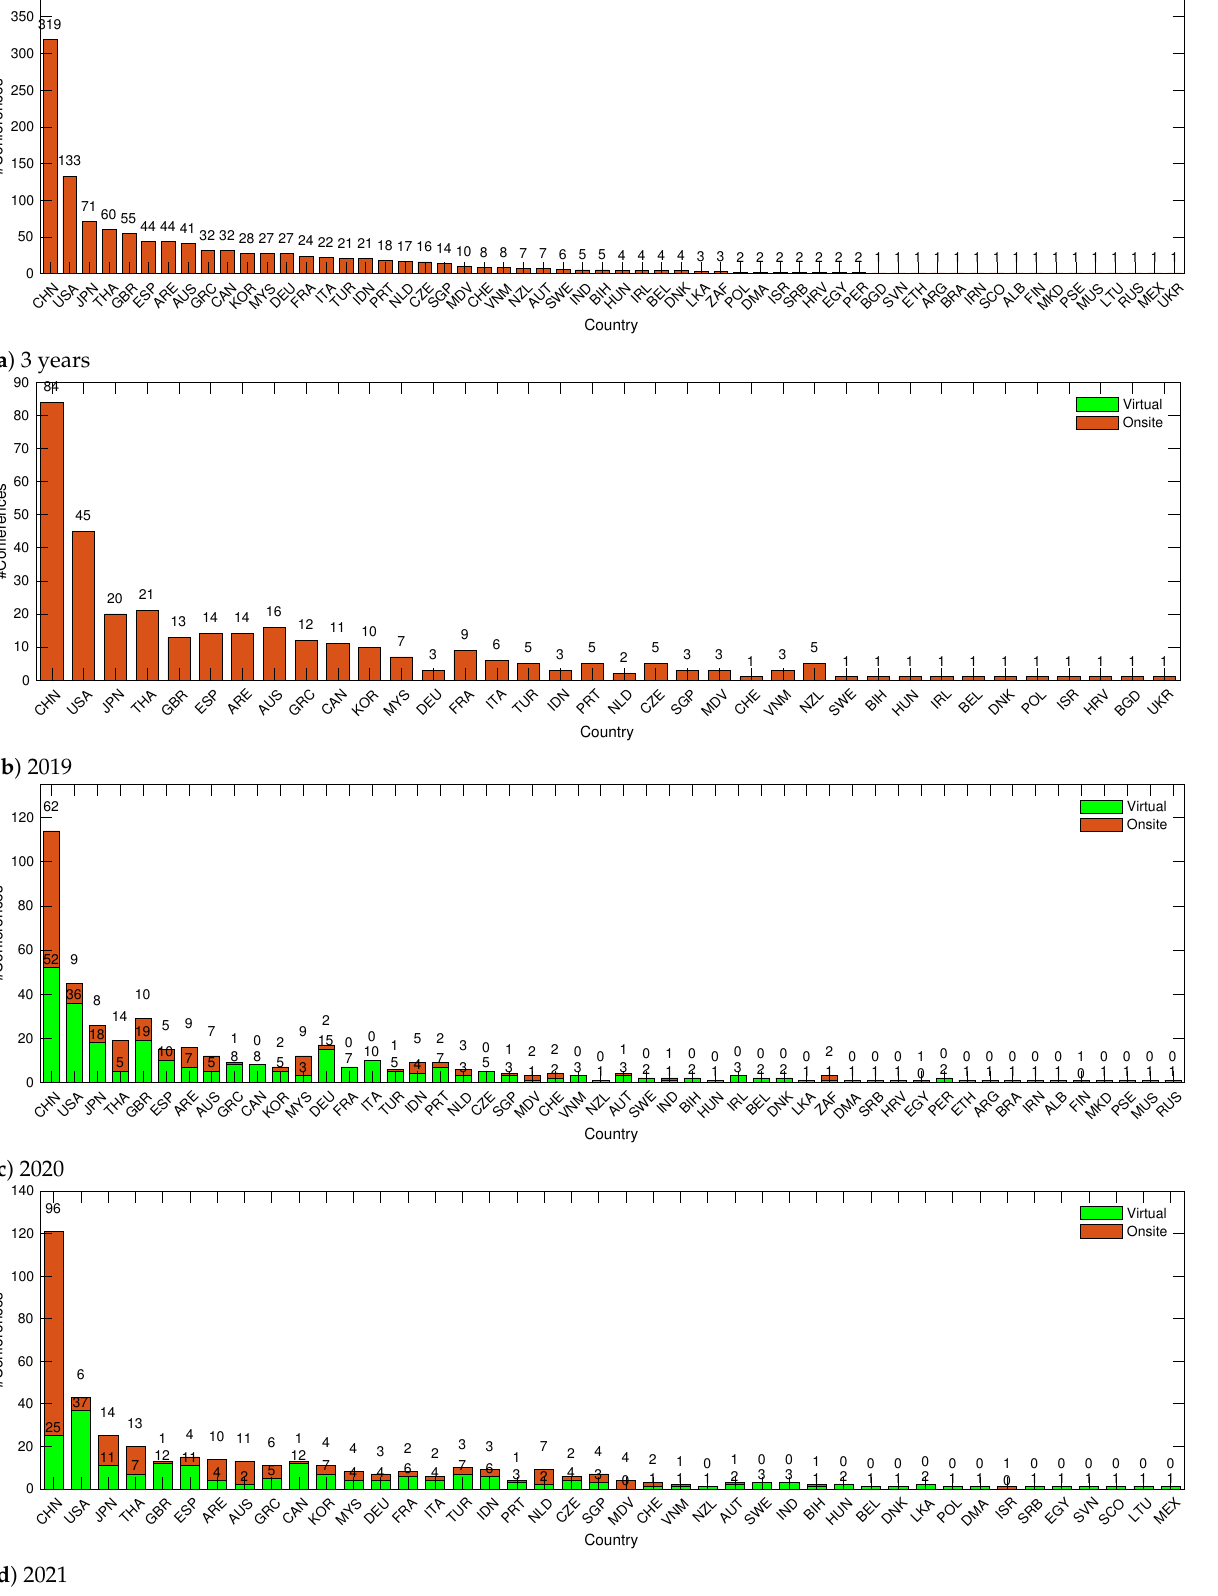
Figure A1. Number of conferences held by each country. ( a ) Ranking of the countries by the number of conferences they held over the three years. ( b – d ) Number of virtual and onsite conferences held by each country in 2019, 2020 and 2021,